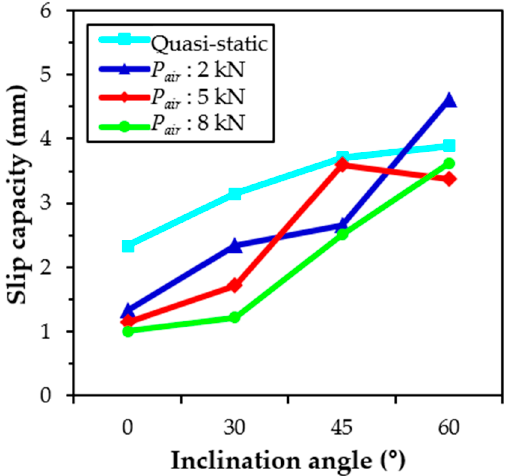
Figure 13. Effects of loading rate and inclination angle on slip capacity of H-fibers in UHPC (Note: P air = air pressure).